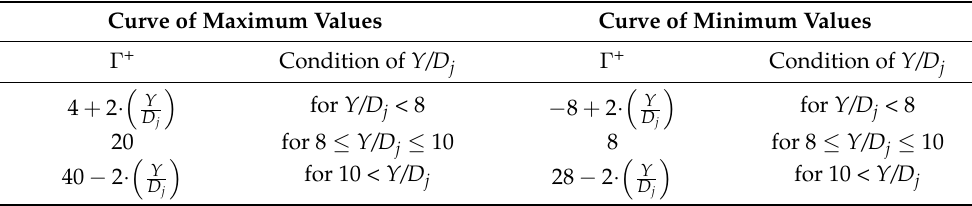
Table 9. Conditions for computing the amplification factor ( Г + ) [63].